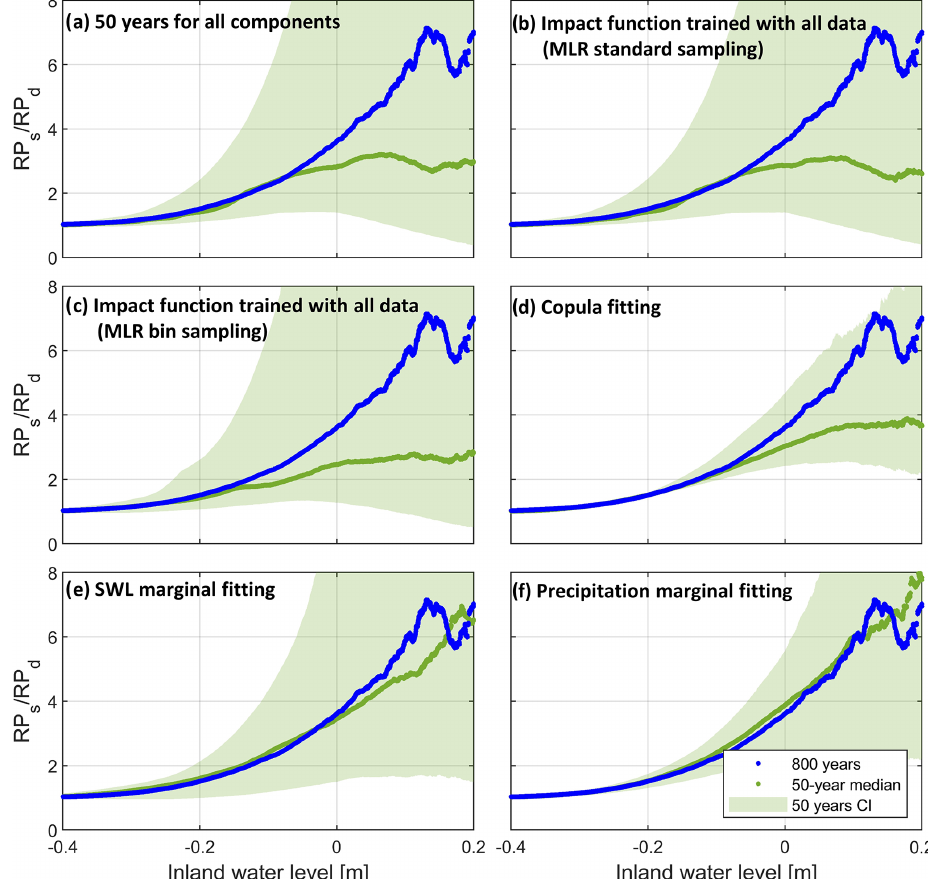
Figure 10. Compound effect (estimated as ratio between return periods as obtained from shuffled and original data) against IWL return level using a bivariate copula. Blue dots depict the values obtained using the proposed statistical framework (using 800 years of data). Transparent green illustrates the uncertainty associated with internal climate variability, represented by bounds computed using the 5th and 95th percentiles from all 50-year ensembles. Opaque green shows the median value computed from all ensembles. This is assessed for each component of the methodology: (a) 50-year ensembles are used for all components; (b) same as (a) but MLR impact function is trained with standard sampling using 800 years of data; (c) same as (b) but using bin-sampling approach; (d) 50-year runs are used for copula fitting only; (e) 50-year runs are used for SWL marginal fitting only; and (f) 50-year runs are used for precipitation marginal fitting only (see Table